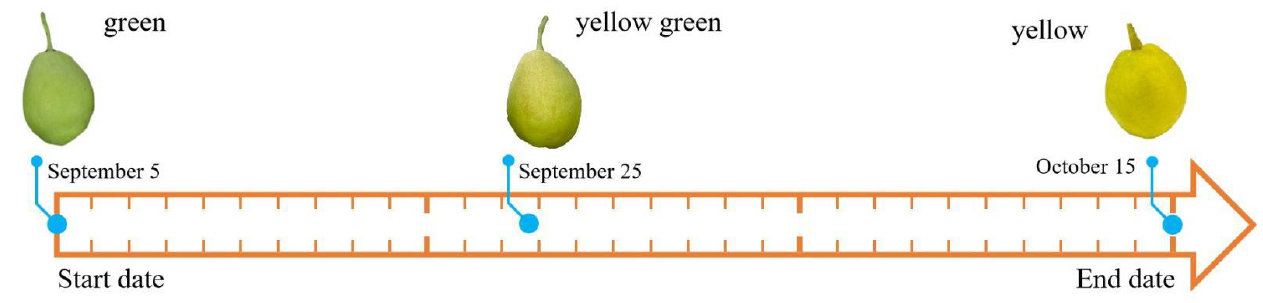
Figure 1. Color variation of fragrant pears during the harvesting period.